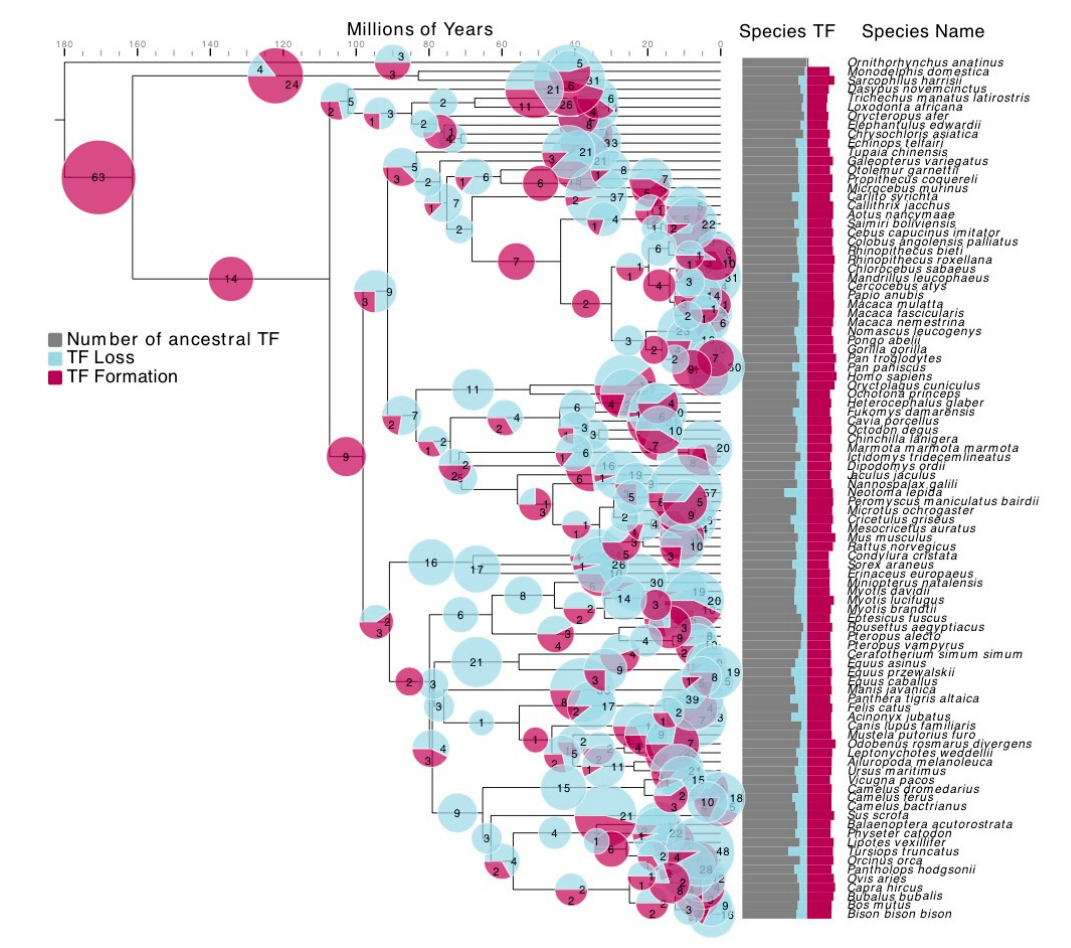
Figure 2. Atlas of formation and loss events in 48 transcription factor (TF) families from 96 mammalian species over 177 million years. The size of each pie chart is proportional to the number of TF gains and losses on each branch; light blue indicates TF loss events, and red indicates TF formation events. The bar chart displays the total number of TF gains (red) and losses (blue) in each species over 177 million years. The gray bars indicate ancestral TFs. Species tree is from TimeTree [28] .